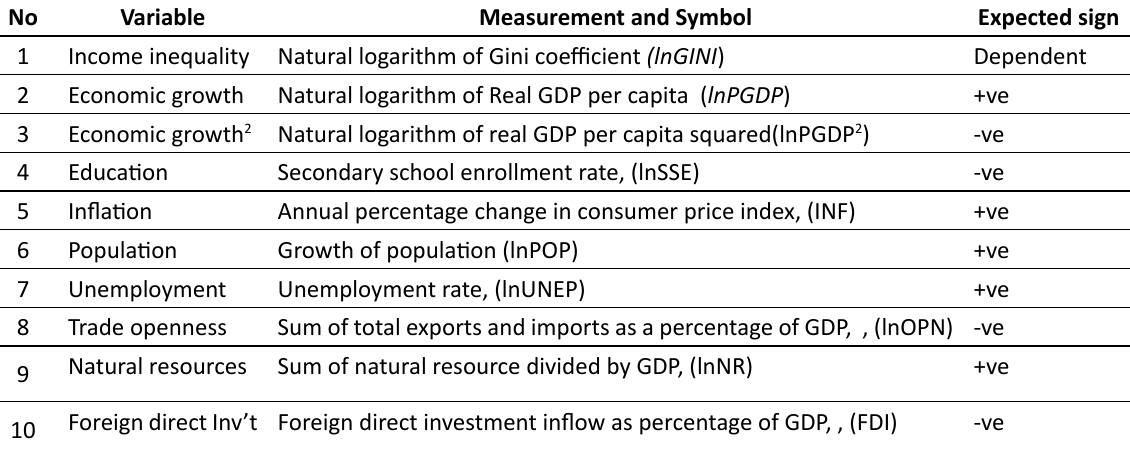
Table 1: Summary of Variable Description, Measurement and Expected Sign